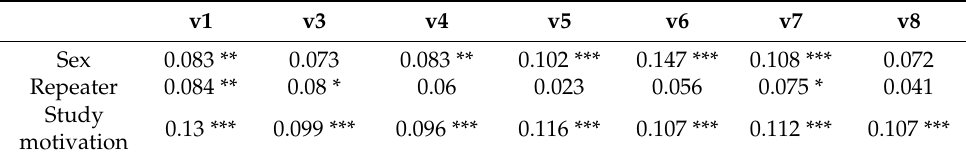
Table 4. Cramer’s V test. Perception of competences in terms of what has been learnt.